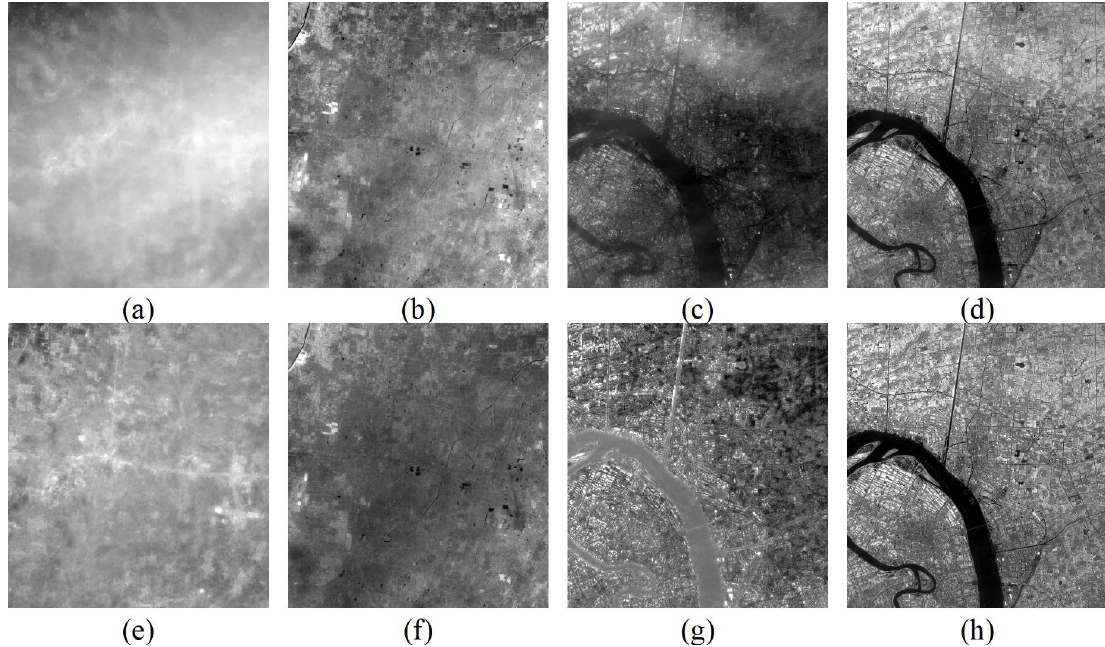
Figure 13. Dehazing results in other bands: ( a ) coastal/aerosol band (0.43–0.45 μm) of Figure 10c; ( b ) near-infrared band (0.85–0.88 μm) of Figure 10c; ( c ) coastal/aerosol band of Figure 11c; ( d ) near-infrared band of Figure 11c; ( e – h ) dehazed results of ( a – d ) respectively.